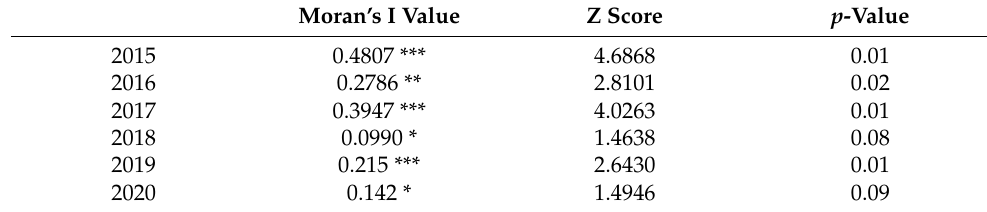
Table 2. Global Moran’s I of the ULGUE in Lanzhou-Xining urban agglomeration.